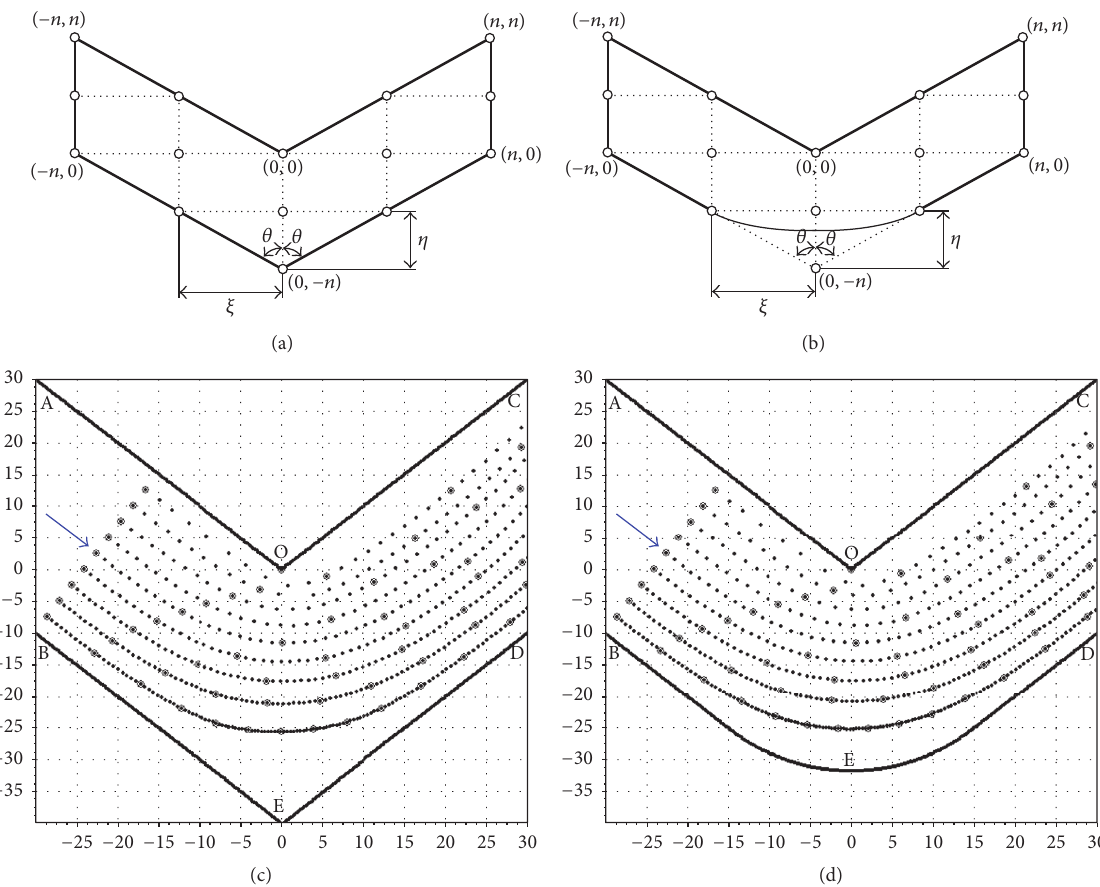
Figure 3: The finite difference meshes (a, b) and the computational flow lines (c, d) with dead zone formation (p. E) in vicinity of the external obtuse angle ∠ (BED) (a, c) and for the “dead zone free” viscous flow (b, d) of a plasticine workpiece model through obtuse-angled equal channel angular dies AOC–BED of Segal (a, c) and Iwahashi geometries (b, d) with channel intersection angles ∠ (AOC) = 2 𝜃 = 105 ∘ and external rounding BED in channel intersection zones 𝑅 = 15 mm (b, d), where the time distance between small points of computational flow lines is 3 s, and the time distance between circles of computational flow lines is